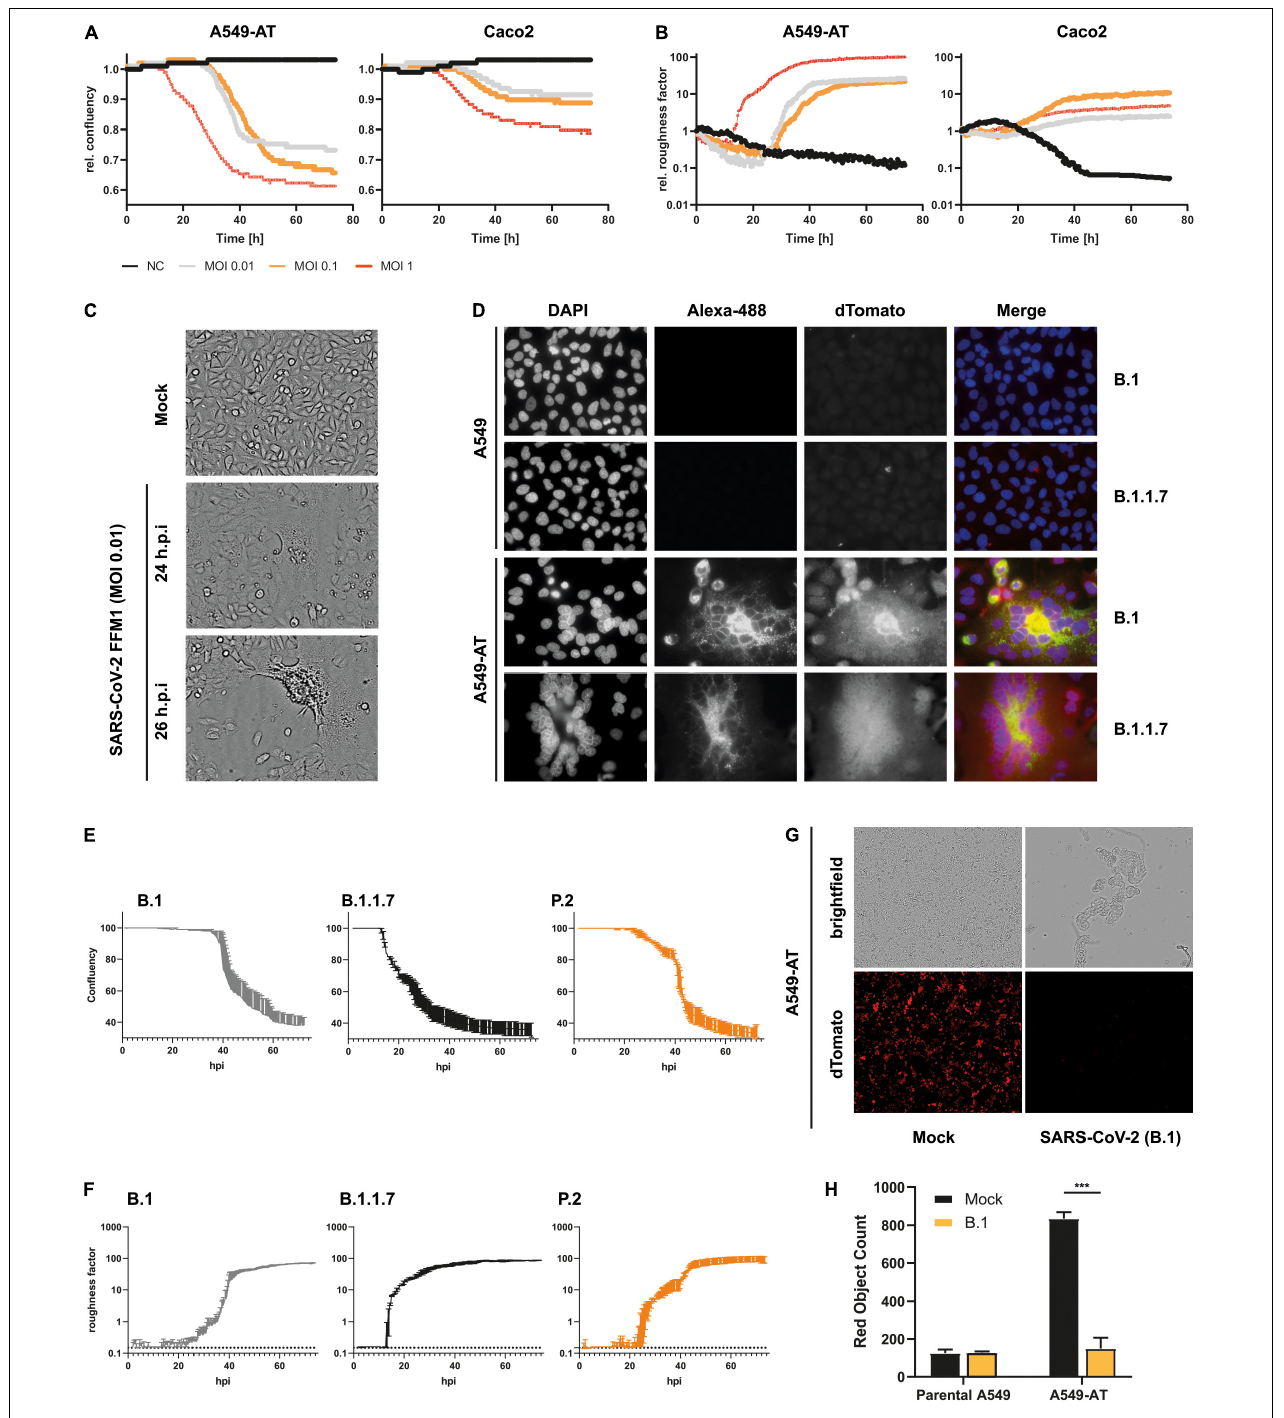
FIGURE 5 | Monitoring of SARS-CoV-2 infection and CPE formation. (A,B) Caco2 and A549-AT cells were infected with SARS-CoV-2 strain FFM1 with the indicated MOI. Relative confluency and roughness of infected cells was analyzed in an automated live-cell-imaging system in continuous measurement over the specified period in 37 ◦ C and 5% CO 2 . (C) Imaging of SARS-CoV-2 (FFM1) infected A549-AT cells showing induced syncytia and CPE formation. (D) Fluorescence imaging of SARS-CoV-2 (B.1 and B.1.1.7) infected parental A549 and A549-AT cells. SARS-CoV-2 Spike was stained with an Alexa-488-coupled antibody and cellular dTomato was used to visualize syncytia formation. (E,F) Relative confluency and roughness of cells infected with SARS-CoV-2 variants B.1 (FFM7), B.1.1.7, and P.2. Analysis was performed as described in A. (G) Representative fluorescence imaging of A549-AT cells constitutively expressing dTomato enabling the detection of SARS-CoV-2 induced cell lysis. (H) Red object count was used to quantitate the loss of dTomato fluorescence in SARS-CoV-2 infected cells shown in E. The figure shows the representative results of at least two independent experiments. *** p < 0.001.